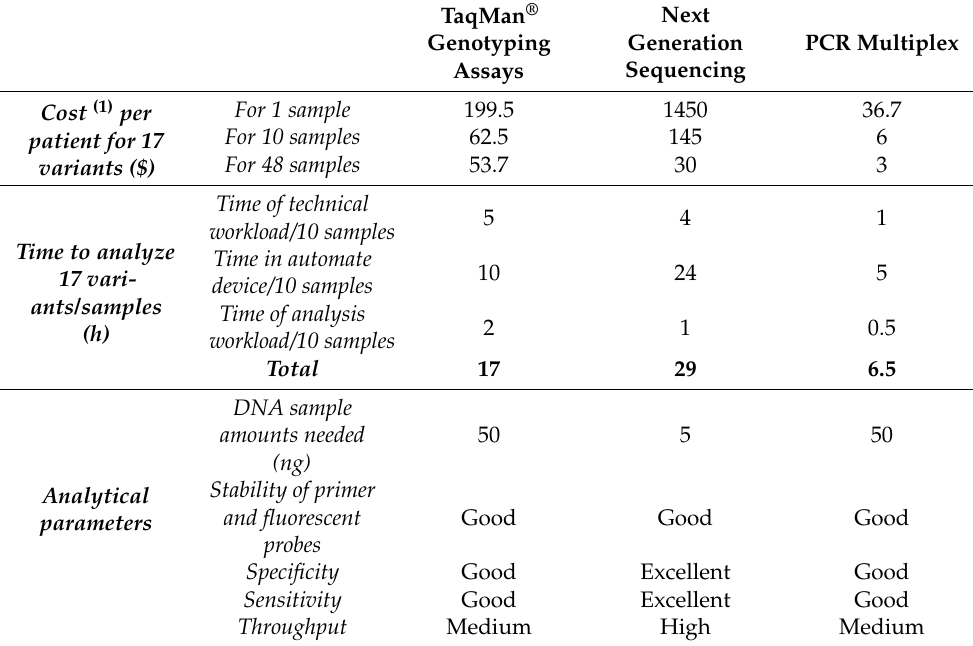
Table 5. Comparison of cost and analytical workflow with reference